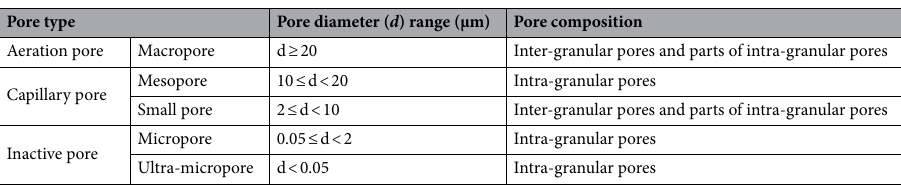
Table 4. Classification of pore types in the saline–alkali soils in this study.